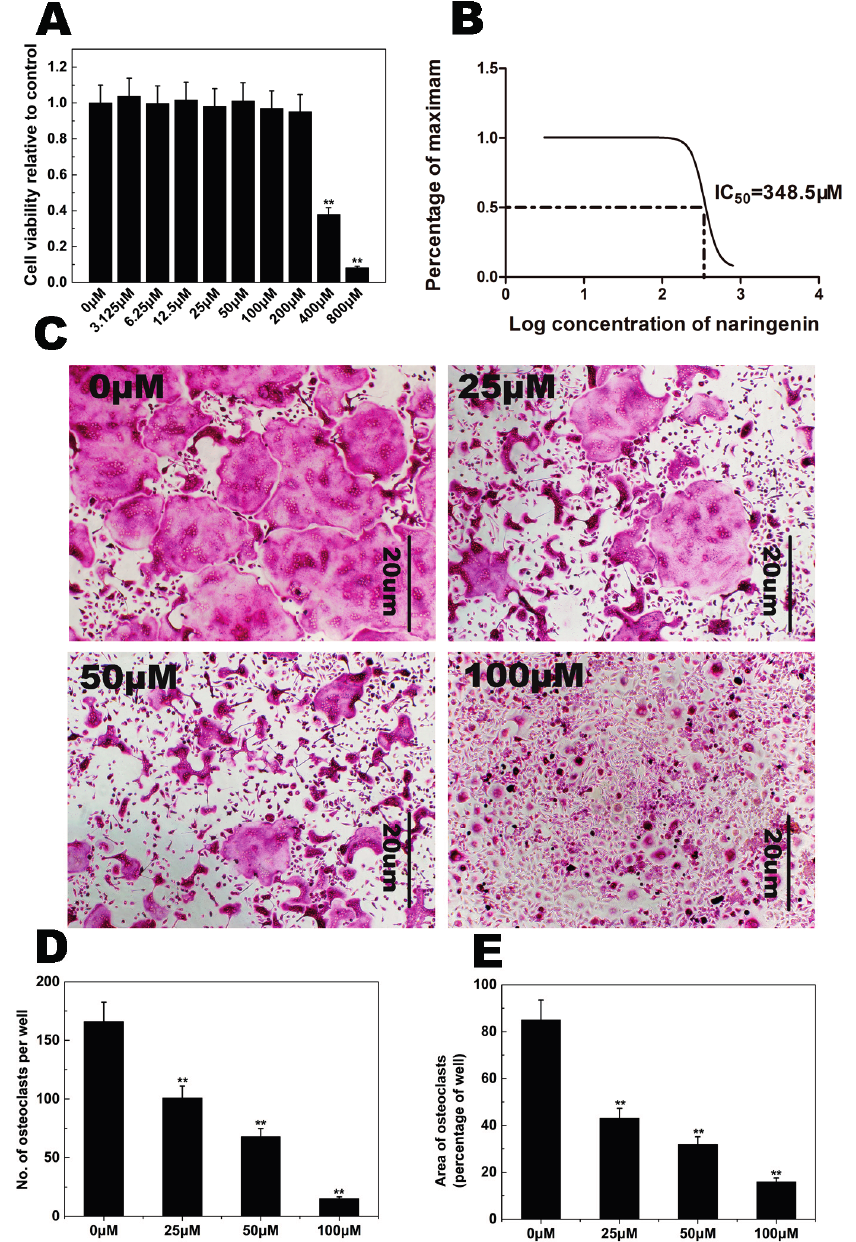
Figure 2. Naringenin (NAR) inhibited receptor activator of the nuclear factor- κ B ligand (RANKL)-induced osteoclastogenesis. ( A ) Bone marrow macrophages (BMMs) were cultured in complete α -MEM medium containing the indicated concentrations of NAR for 48 h. Cell viability, relative to control, was measured by CCK-8 assay; ( B ) The inhibition of BMM viability was analyzed using GraphPad Prism software (GraphPad Software, La Jolla, CA, USA), and the half-maximal inhibitory concentration (IC 50 ) was determined to be 348.5 μ M; ( C ) BMMs were treated with different concentrations of NAR followed by 30 ng/mL macrophage colony-stimulating factor (M-CSF) and 50 ng/mL RANKL for 5–7 days. Cells were then fixed with 4% paraformaldehyde and stained for tartrate-resistant acid phosphatase (TRAP); ( D ) The number of TRAP-positive cells; ( E ) The area occupied by TRAP-positive cells. ** p <